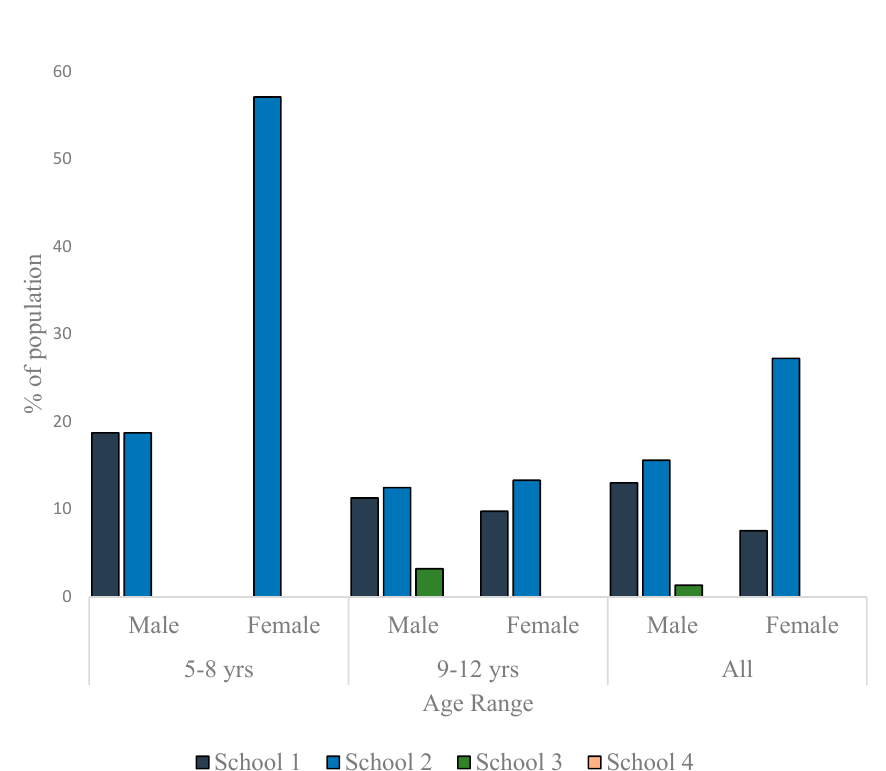
Figure 3. Prevalence of thinness among children in the studied schools. Children 2016 , 3 , x FOR PEER REVIEW